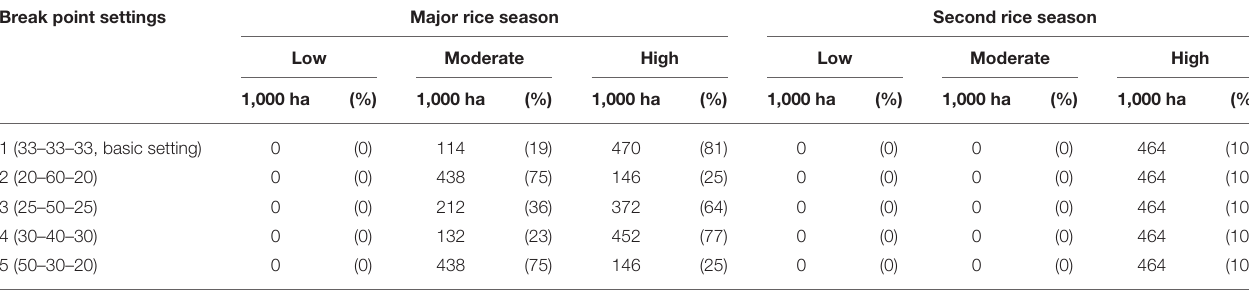
TABLE 5 | Sensitivity analyses on the settings of breakpoints for the major and second seasons. Break point